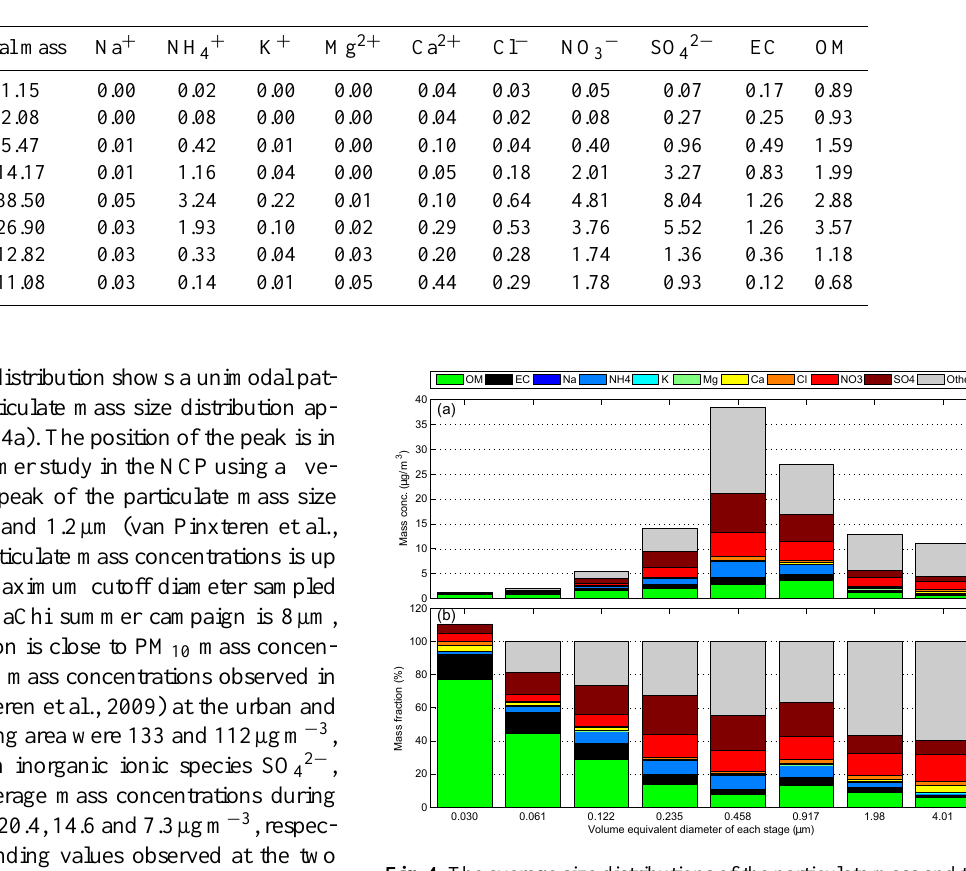
Fig. 4. The average size distributions of the particulate mass and the chemical composition during the HaChi campaign. Panel (a) shows the mass concentration of all species and panel (b) shows the rel- ative mass fractions in individual impactor stage. OM is converted from OC by a conversion factor of 1.6 (Turpin and Lim, 2001; Xing et al.,